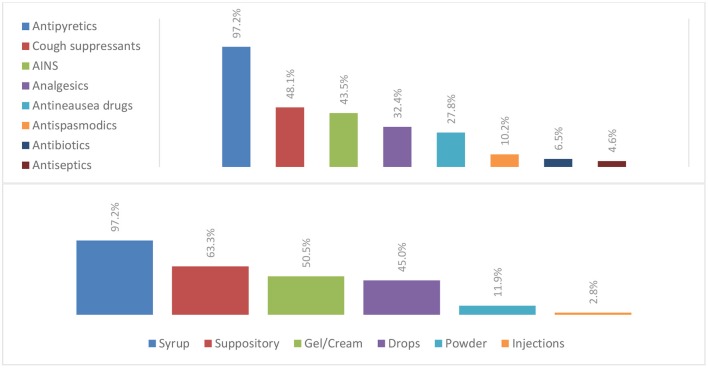
Phone-prescribed drugs and their different forms.